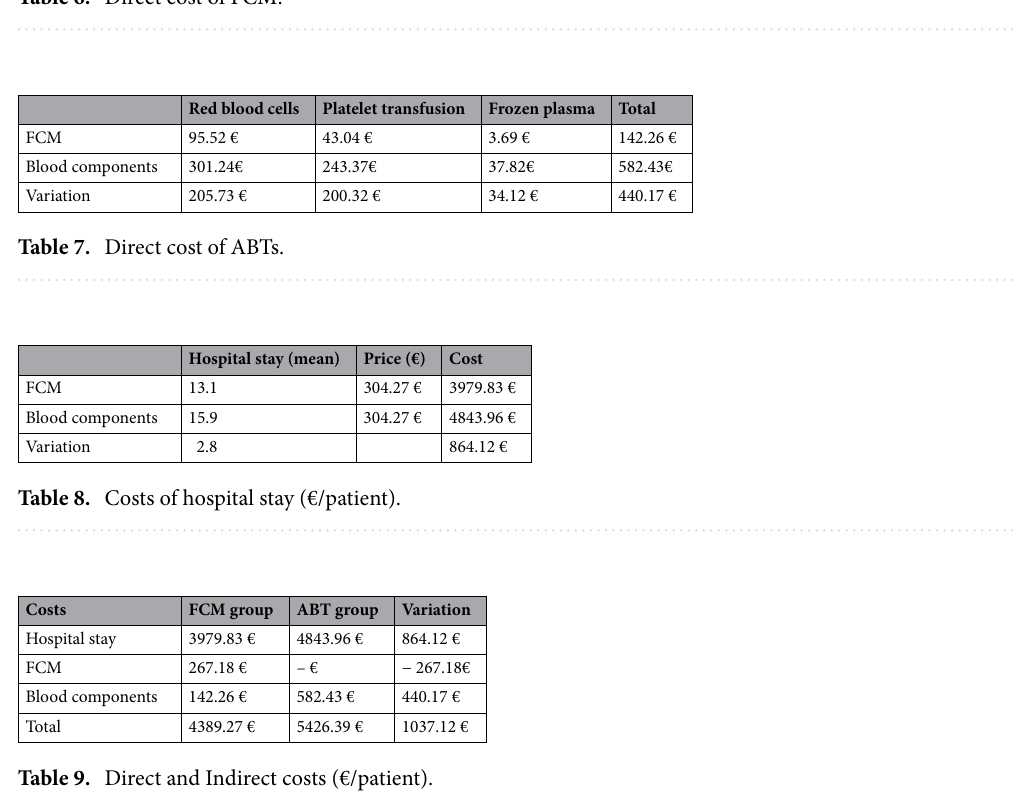
Table 6. Direct cost of FCM.